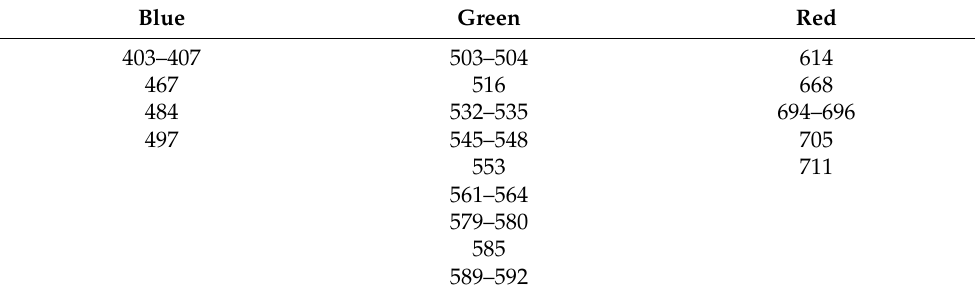
Table 9. Most-significant spectral bands selected by stepwise procedures. Blue, green and red are the wavelength